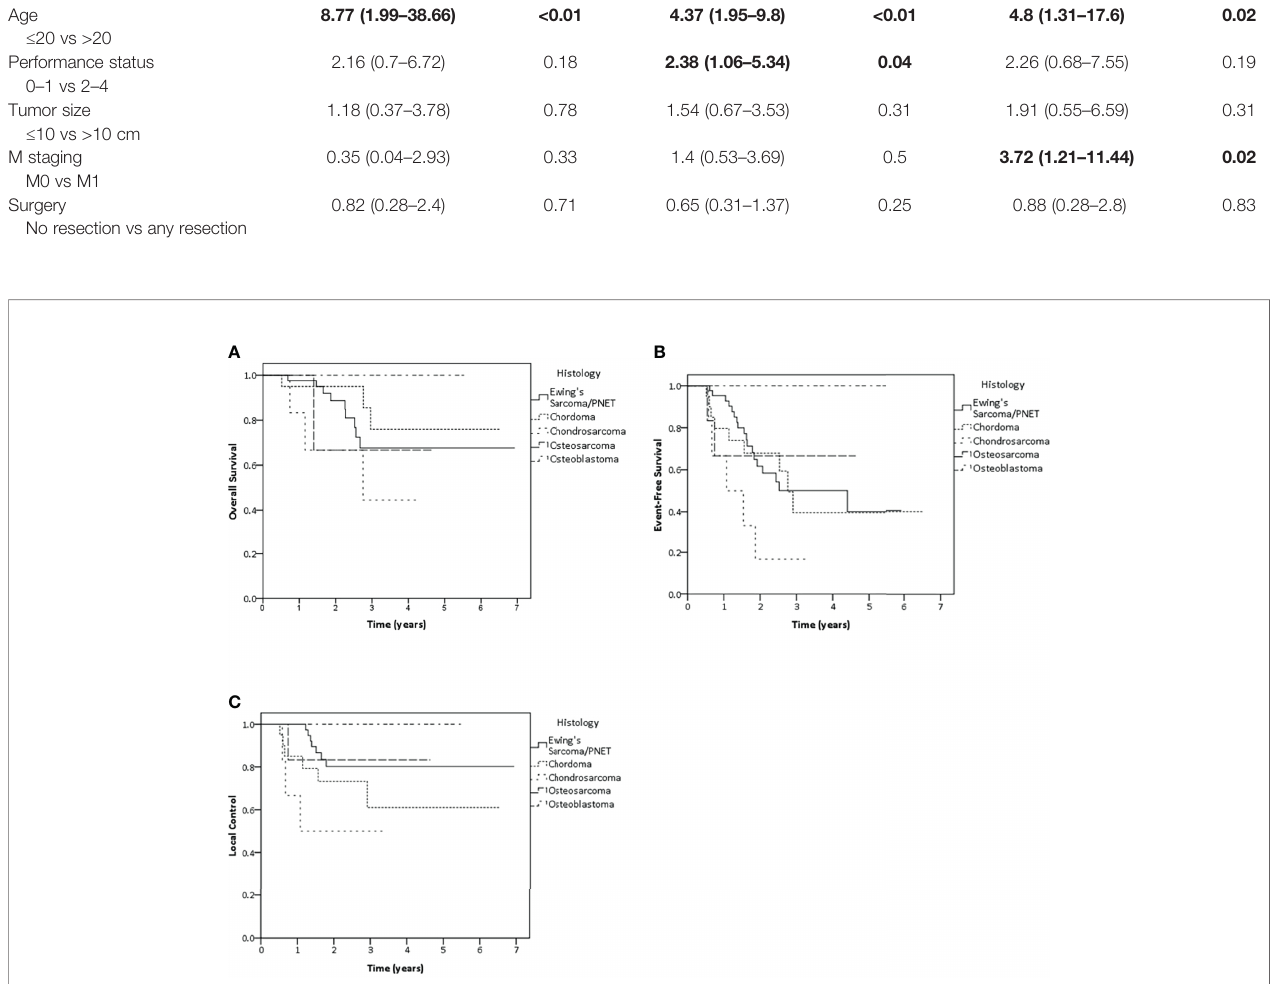
FIGURE 3 | Kaplan – Meier estimates of overall survival (A) , event-free survival (B) and local control (C) rates according to